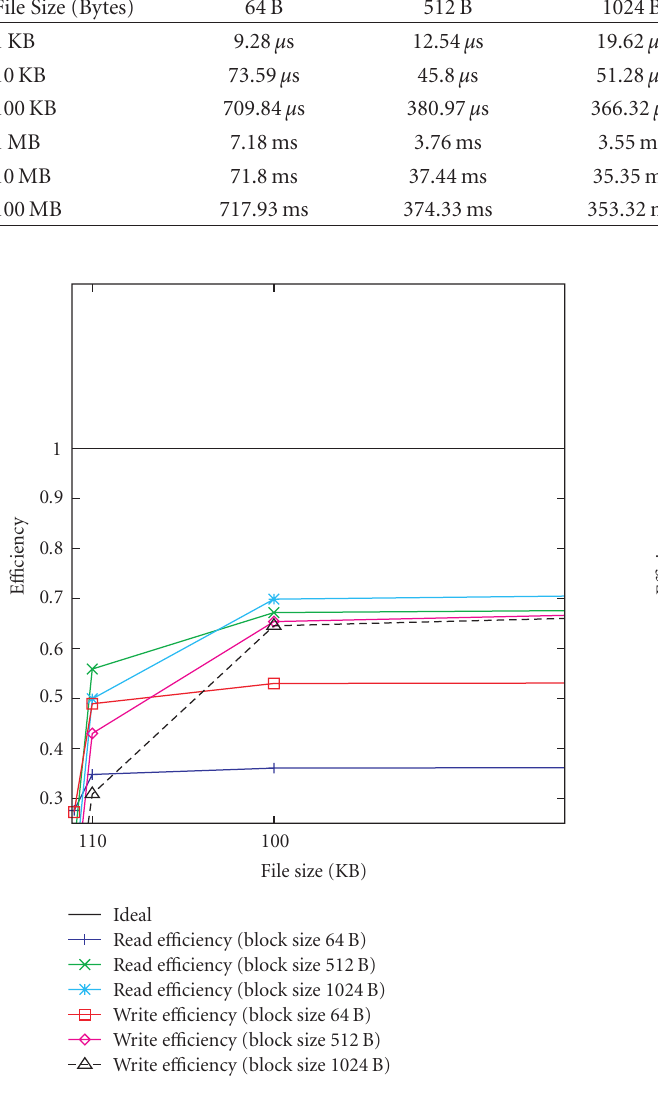
Figure 14: HWFS sequential read/write e ffi ciency with single RAM disk plotted against di ff erent file sizes.